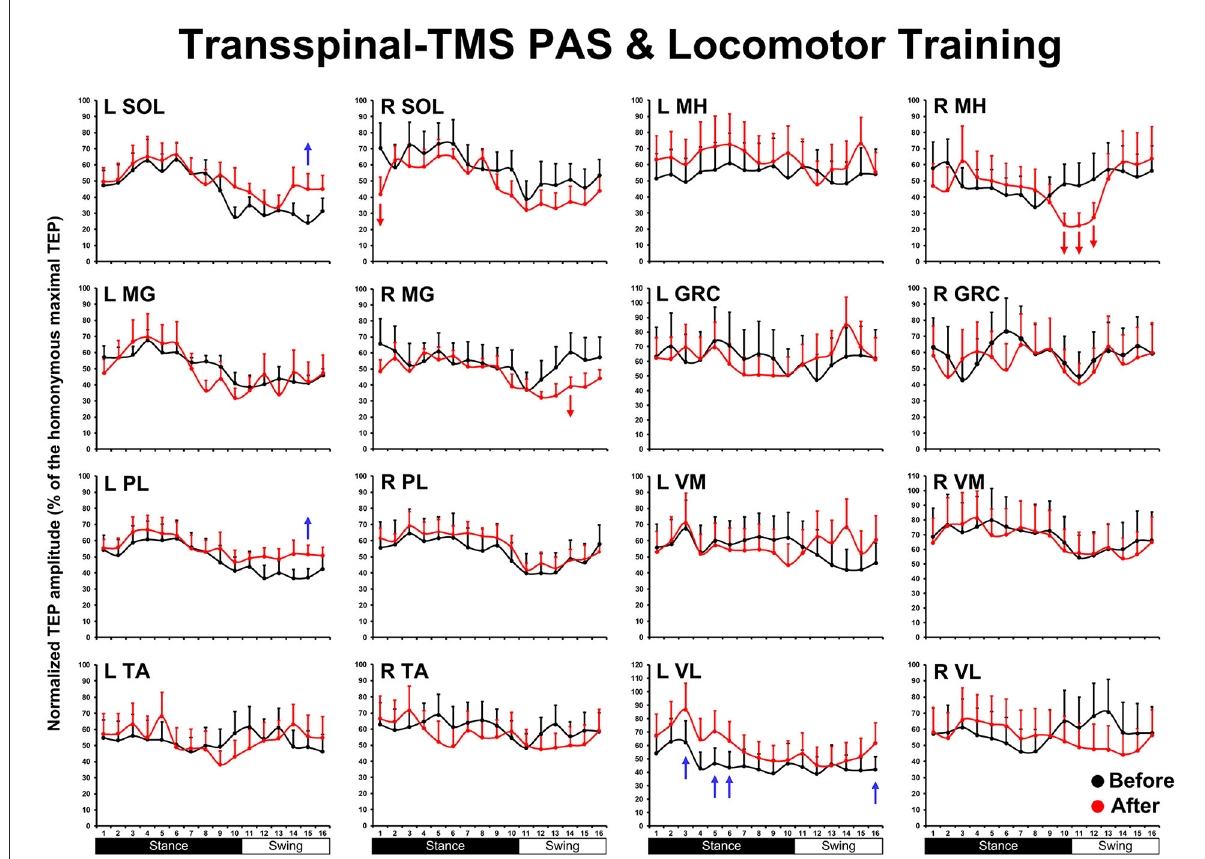
FIGURE1 The mean amplitude of TEPs, from all subjects, recorded during assisted stepping from left and right muscles before (black) and after (red) transspinal-TMS PAS and locomotor training are normalized to the maximal homonymous TEP and plotted against the step cycle divided into equal 16 bins. Red arrows indicate depression and blue arrows indicate facilitation. Error bars indicate the SEM. SOL, soleus; MG, medial gastrocnemius; PL, peroneus longus; TA, tibialis anterior; MH, medial hamstring; GRC, gracilis; RF, rectus femoris; VL, vastus lateralis; TMS, transcranial magnetic stimulation; PAS, paired associative stimulation; TEPs, transspinal evoked potentials.